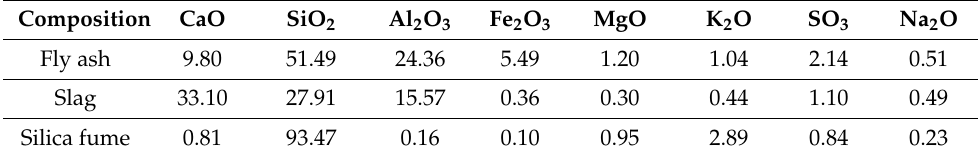
Table 1. Constituents of mineral admixtures as wt.%.